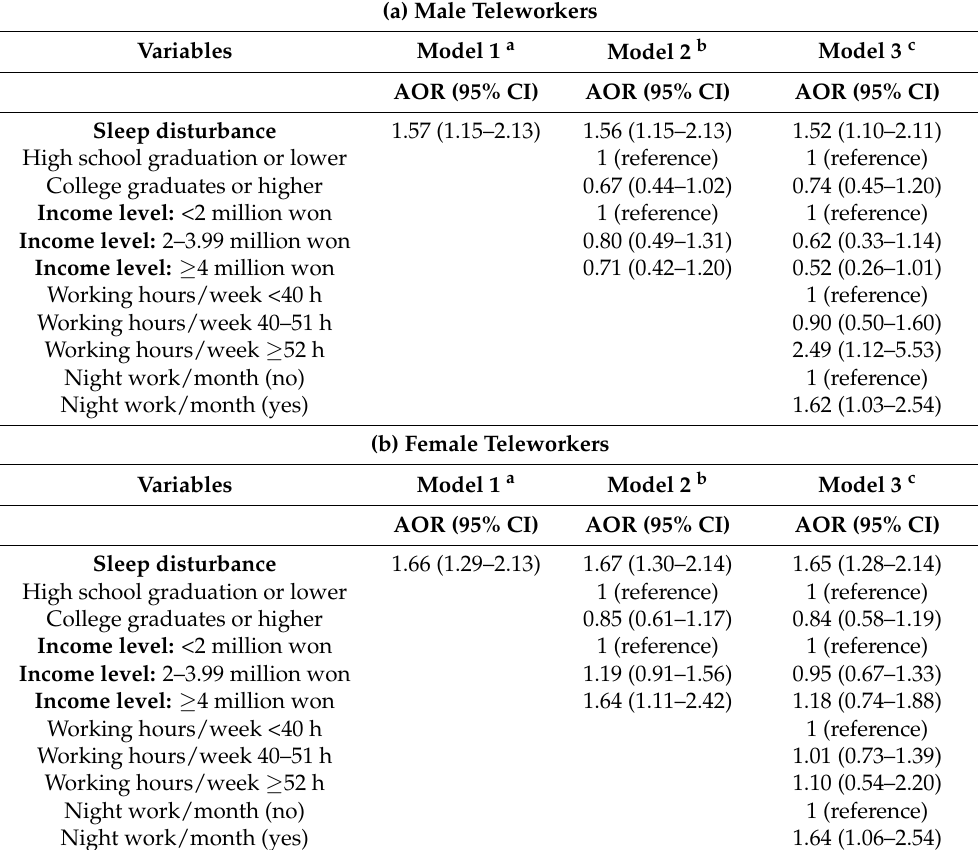
Table 4. Multivariate logistic regression for sleep